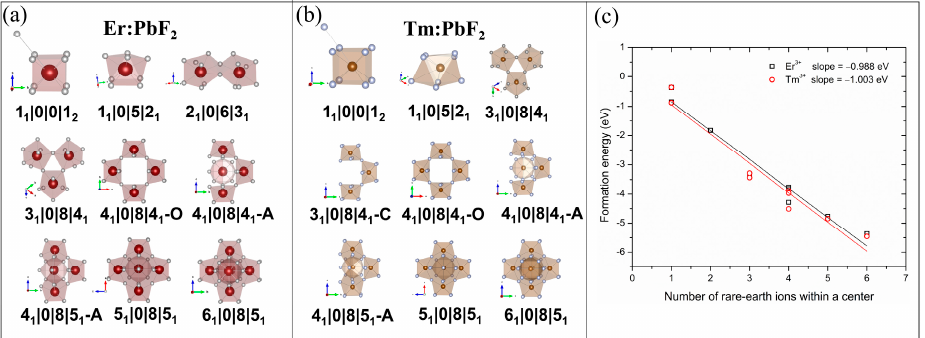
Figure 2. ( a ) Thermodynamically stable Er 3+ centers in PbF 2 crystal; ( b ) Thermodynamically stable Tm 3+ centers in PbF 2 crystal; ( c ) Formation energy of Er 3+ and Tm 3+ versus the number of rare-earth ions within a